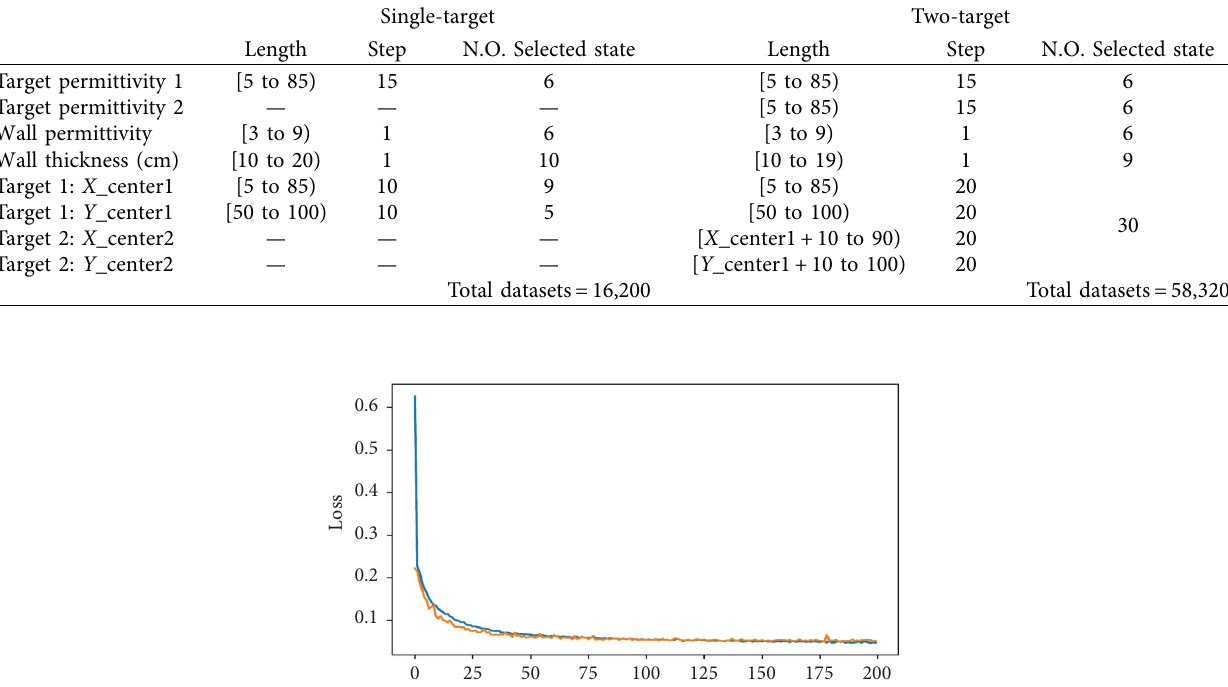
Table 1: A description of the dataset parameters and their values.